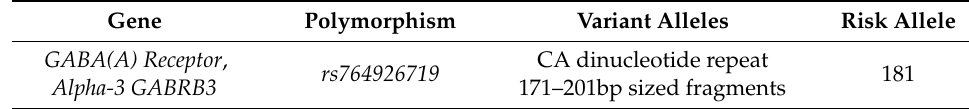
Table 4. Dinucleotide repeats